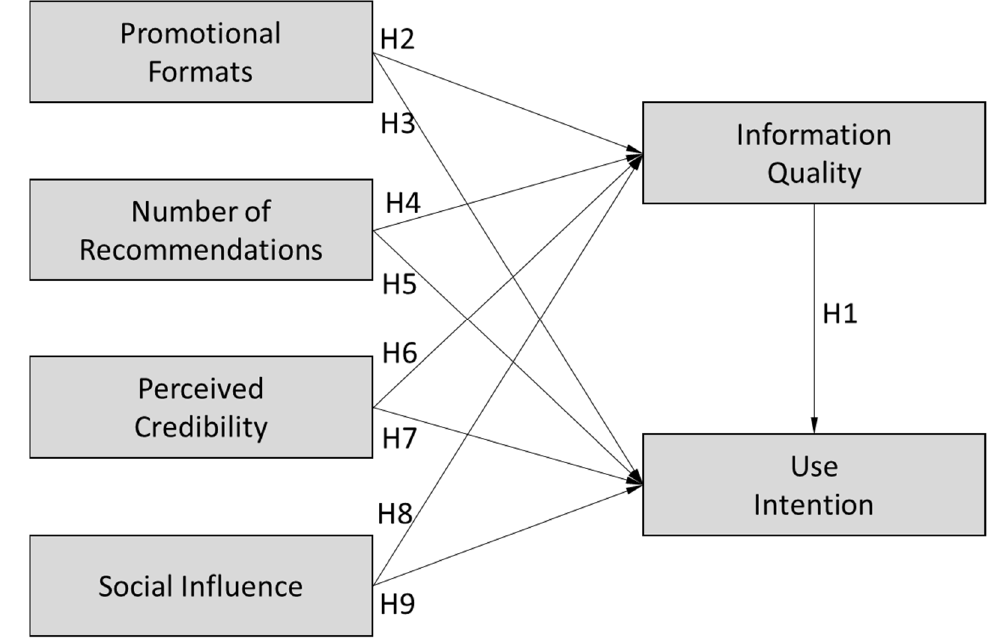
Figure 1. Proposed research model. Table 1. Measurement items and descriptive statistics for all